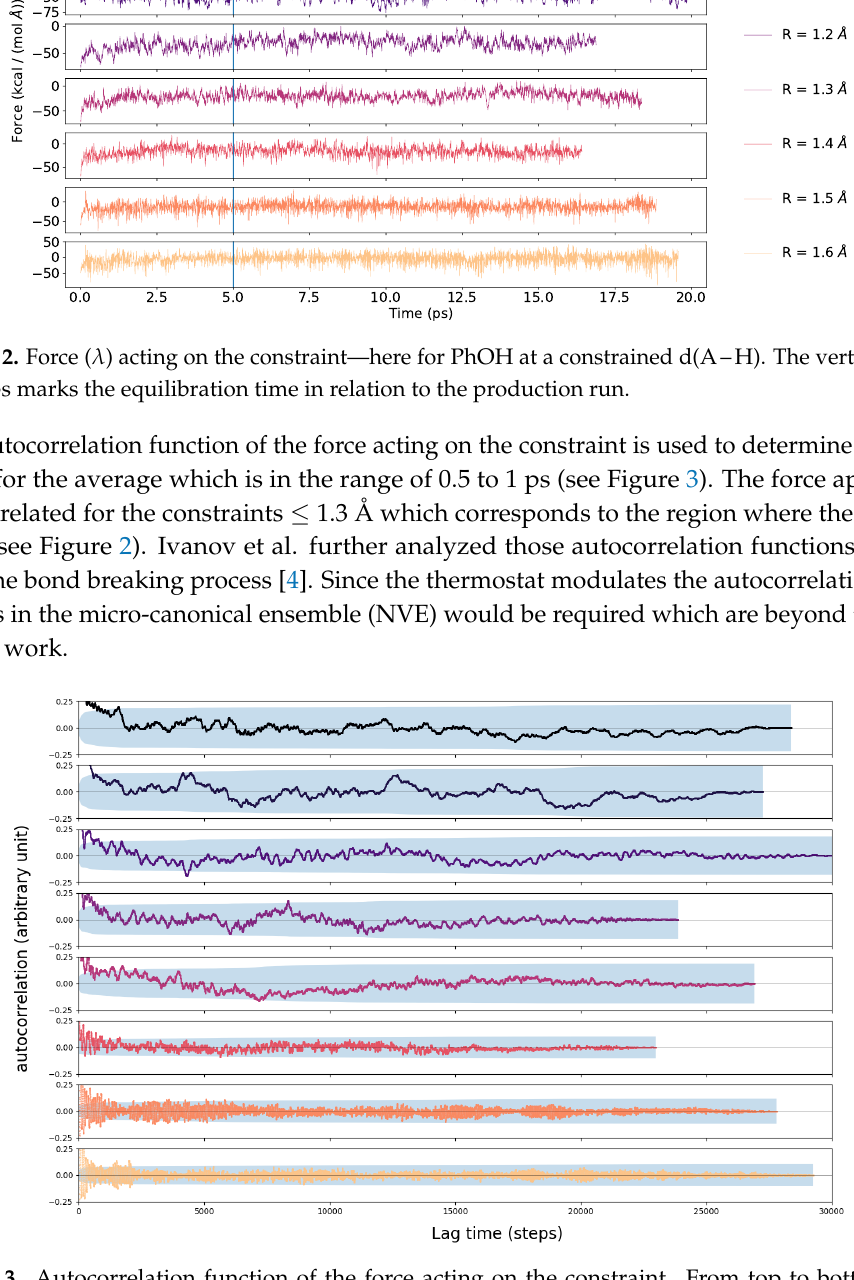
Figure 3. Autocorrelation function of the force acting on the constraint. From top to bottom the constraint increases by 0.1 Å, starting from 0.9